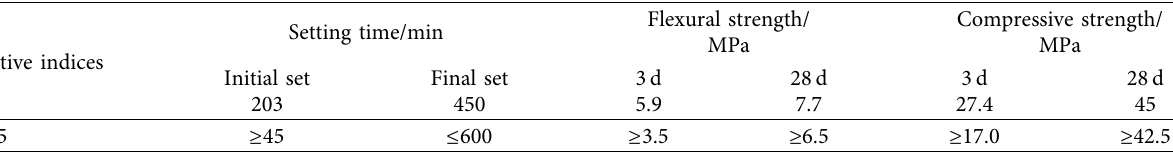
Table 2: Physical and mechanical properties of cement.